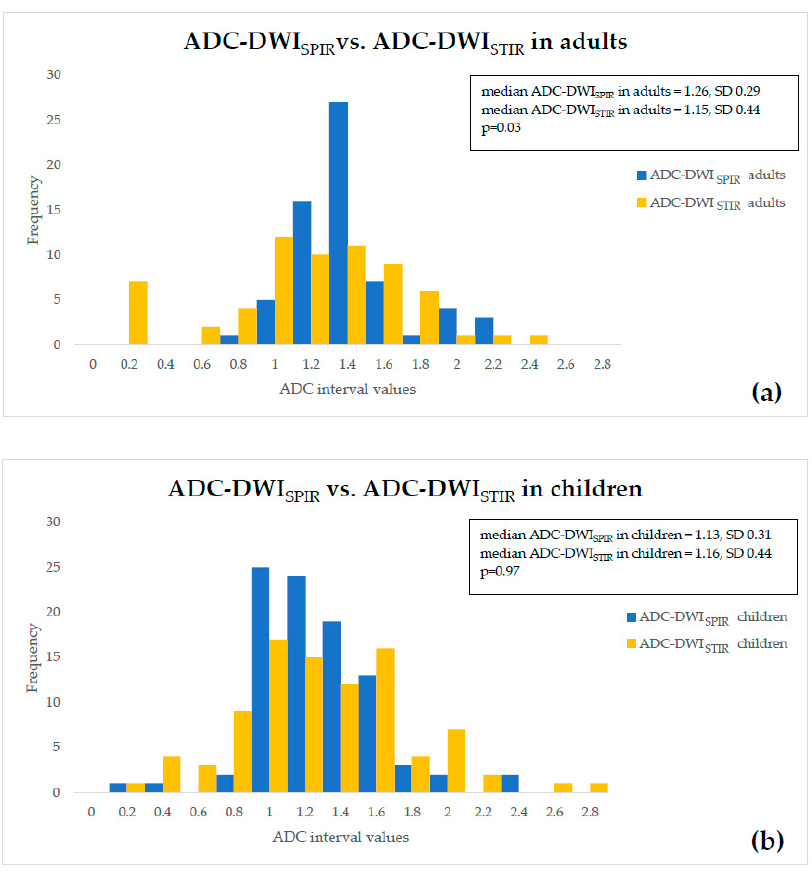
Figure 2. Comparison between ADC-DWI SPIR and ADC-DWI STIR values in the ( a ) adult group and ( b ) in children.